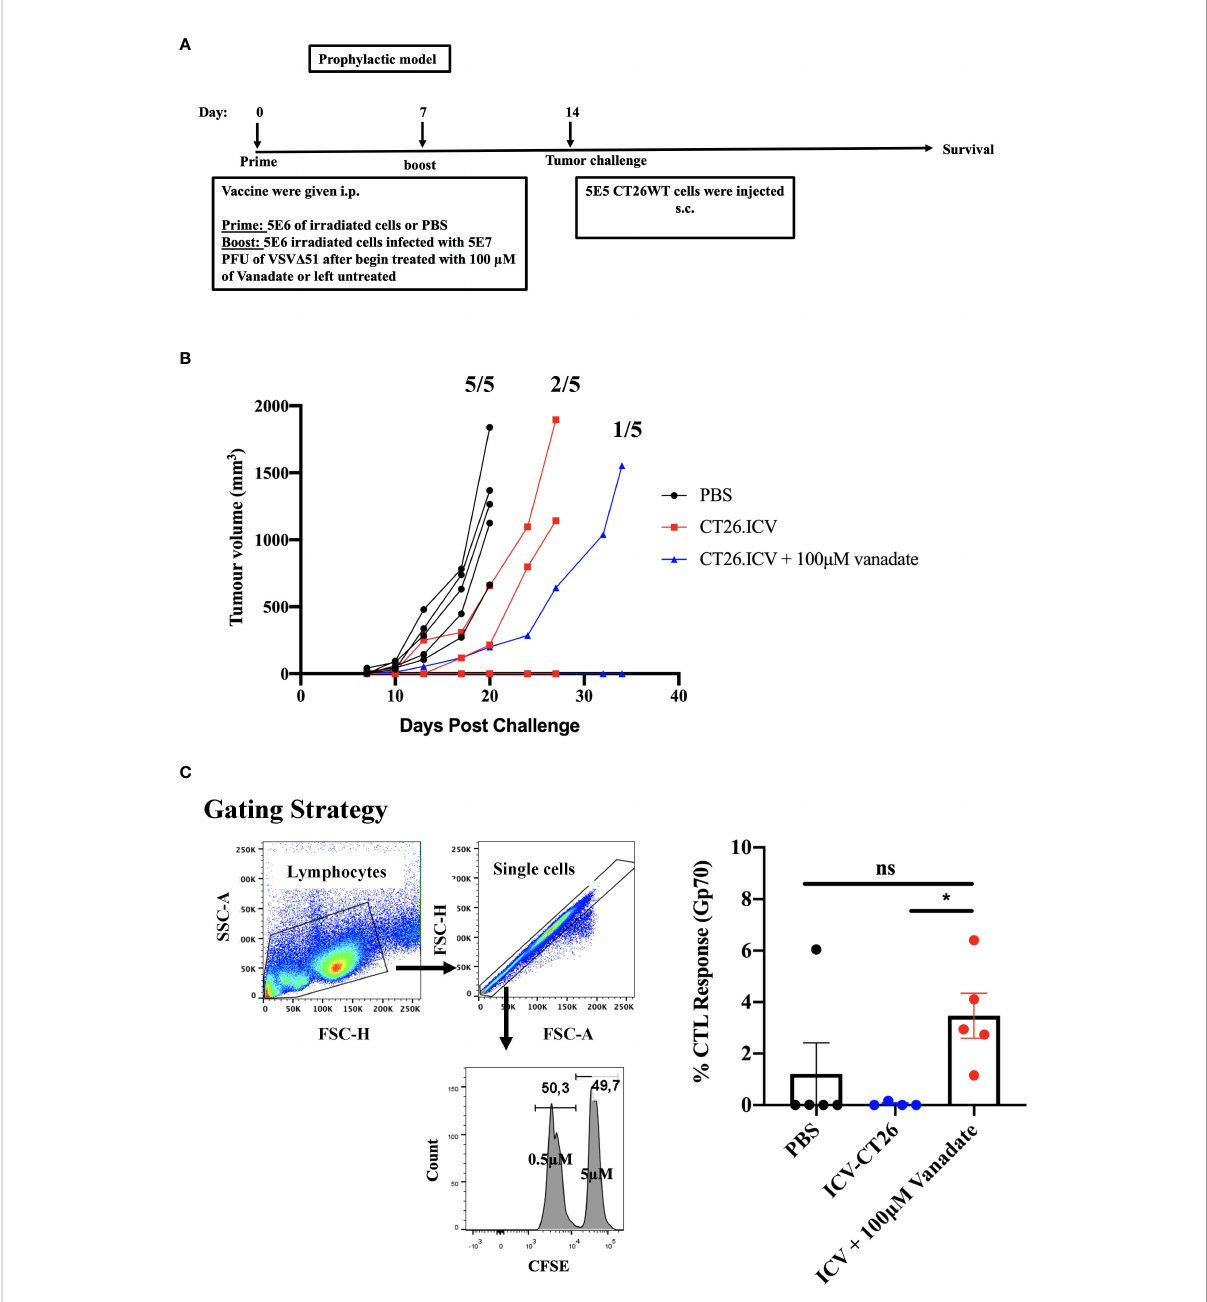
FIGURE 3 VS enhances irradiated infected cell vaccine antigenicity. (A) Schematic representation of the treatment schedule of prophylactic vaccine, CT26WT-tumor bearing mice injected with 5E6 irradiated CT26WT cells i.p. at day 0, and 7 days following that 5E6 irradiated CT26WT cells infected with 5E7 PFU VSV D 51 with and without vanadate were injected i.p. At day 14, CT26WT cells were implanted s.c. (B) Tumor volume of each individual mouse measured over time (n=5 per condition). Fractions indicate the proportion of mice that developed tumors in each group. (C) following the same therapeutic regiment described in A, 7 days post the last treatment, splenocytes from immunized mice were harvested eighteen hours after injecting an equal number of CFSE Hi cells (that were labelled with 5µM CSFE) loaded with gp70 peptide and CFSE Lo cells (labelled with 0.5µM CSFE) unloaded with peptide, in equal proportions of 2E7/200 m l total splenocytes intravenously (i.v.). The proportion of CFSE Hi and CFSE Lo was quanti fi ed by fl ow cytometry by fi rst gating for lymphocytes using forward scatter (FSC) and side scatter (SSC) followed by single-cell gating, the CSFE Hi and CFSE Lo populations. The graph shows the percentage of speci fi c killing against Gp70-CFSE-stained targeted cells compared to control groups. Mean ± SEM; * P = 0.02, One-way ANOVA, n = 5 per conditions. ns, not signi fi